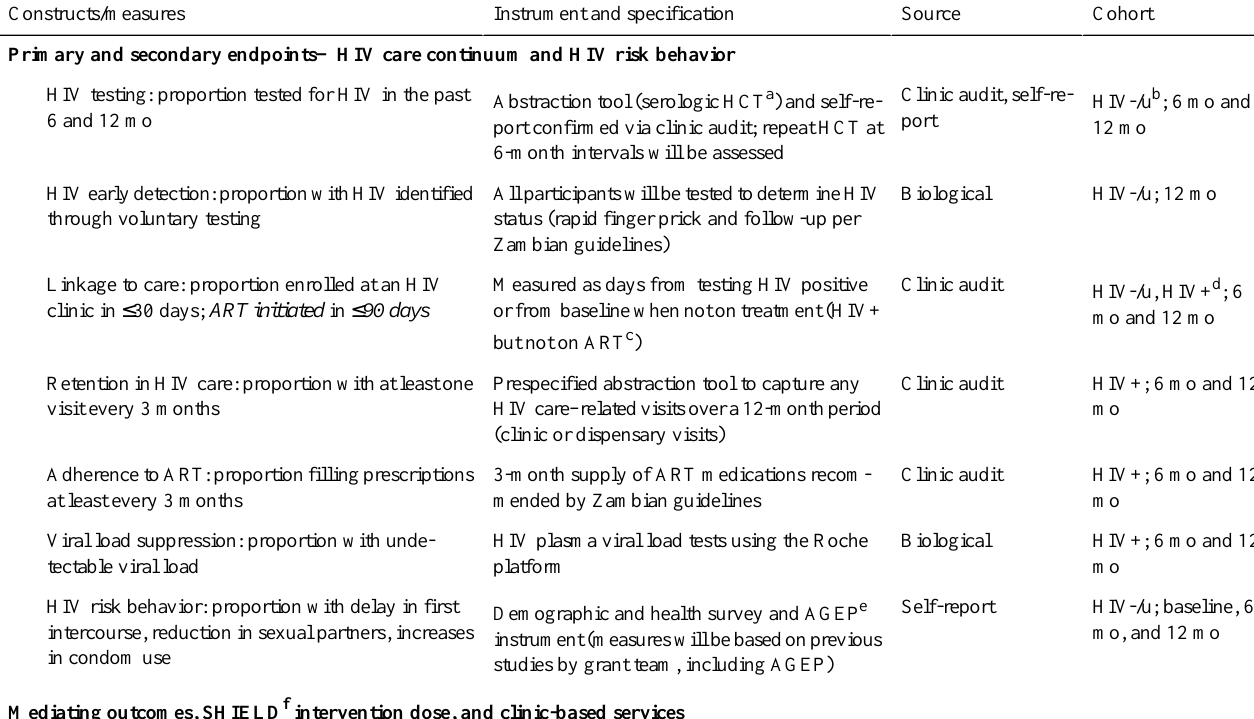
Table 1. Measures and source at baseline, 6 months, and 12